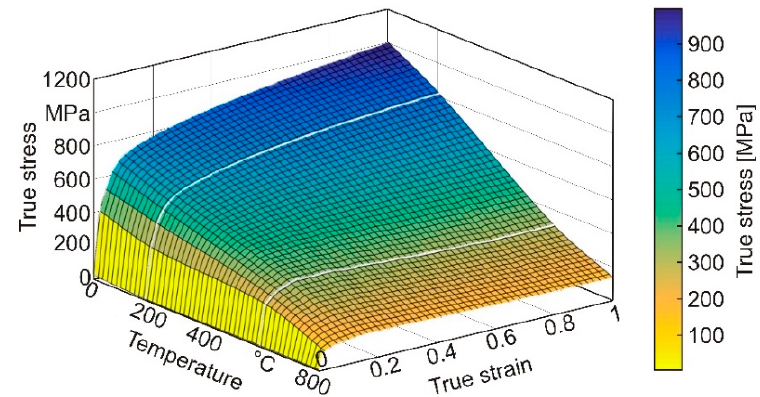
Figure 2. Flow curves of AISI 1045 steel in standardized compression tests at different temperatures.